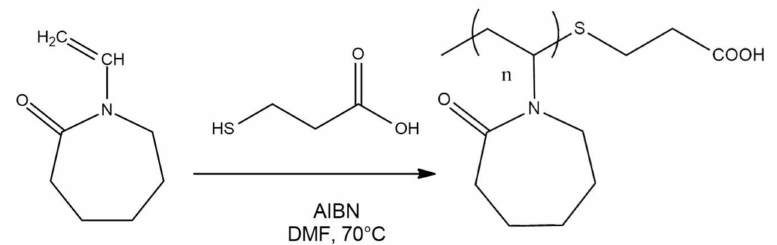
Figure 1. Synthesis of PNVCL-COOH